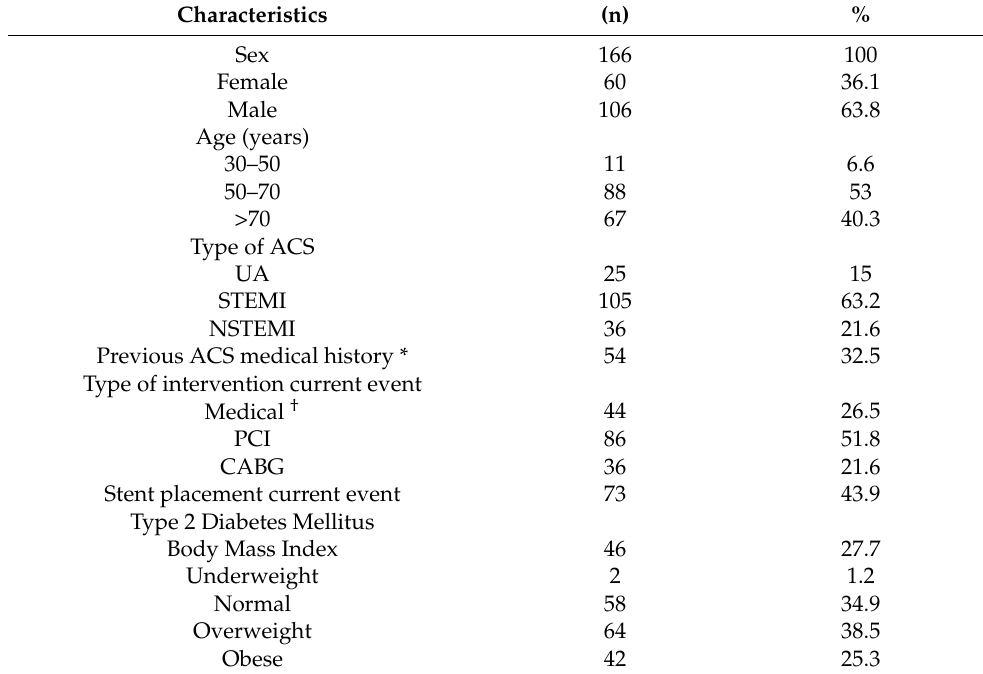
Table 1. Patients’